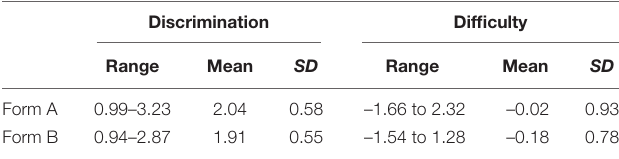
TABLE 6 | Range, mean, and standard deviation of the discrimination and difficulty indices of the ACCE-V Form A and Form